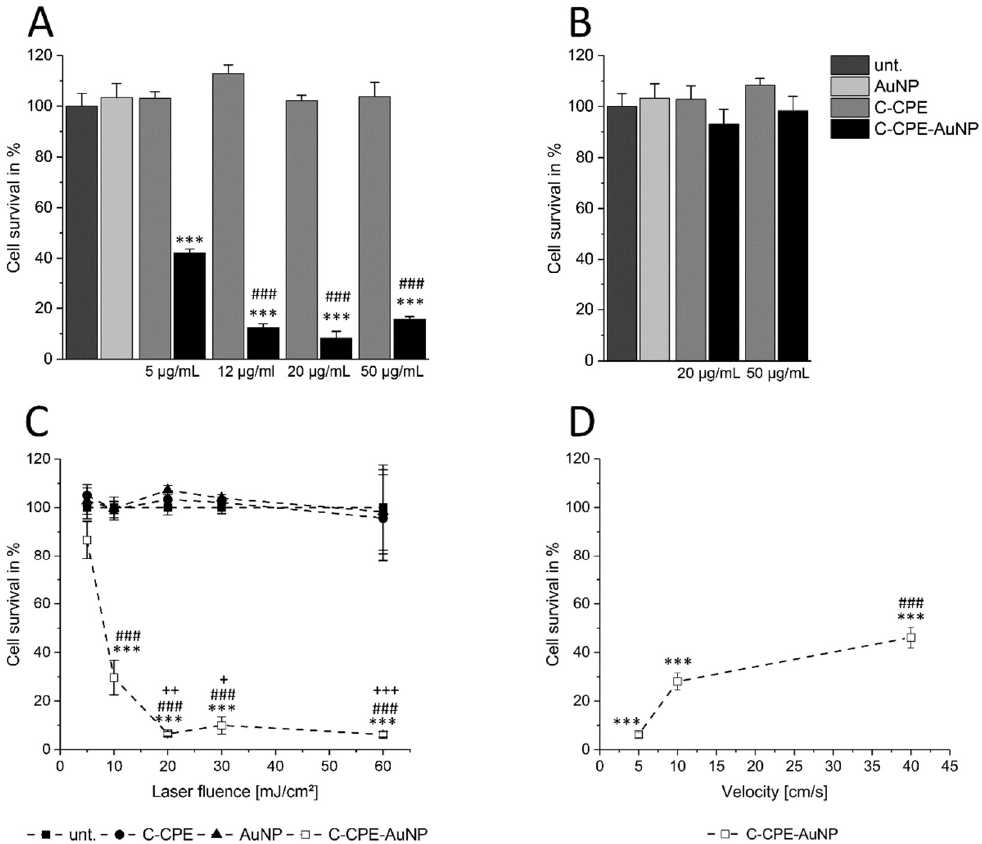
Figure 1. Increased C-CPE concentration for AuNP functionalization increased the efficiency of gold nanoparticle-mediated laser perforation (GNOME-LP)-induced cell killing of Caco-2 cells. ( A ) The survival of Caco-2 cells evaluated by propidium iodide uptake in cells treated with GNOME-LP (30 mJ/cm² at 5 mm/s) in presence of C-CPE, AuNPs, and C-CPE functionalized AuNPs (C-CPE-AuNPs). The increase of C-CPE concentration during functionalization process reduced the cell survival. The results were analyzed with Student’s t test. * Significant difference to the AuNP control group: *** p < 0.001. # Significant difference to 5 µg/mL C-CPE functionalized AuNPs: ### p < 0.001. ( B ) GNOME-LP cell killing with lower laser fluence (5 mJ/cm² at 5 mm/s) in combination with AuNPs functionalized with 20 µg/mL and 50 µg/mL C-CPE did not affect the cell survival. ( C ) Killing efficiency of AuNP functionalized with 20 µg/mL C-CPE and GNOME-LP (30 mJ/cm²) applied at indicated scanning velocity. The results were analyzed with Student’s t test. * Significant difference to the AuNP control group: *** p < 0.001. # Significant difference to velocity of 5 mm/s: ### p < 0.001. ( D ) GNOME-LP with different laser fluence (5–60 mJ/m²; 0.5 s/cm) in combination with 20 µg/mL C-CPE functionalized AuNPs. The results were analyzed with Student’s t test. * Significant difference to the AuNP control group: *** p < 0.001. # Significant difference to laser energy of 5 mJ/cm²: ### p < 0.001. + Significant difference to the laser fluence of 10 mJ/cm²: + p < 0.05, ++ p < 0.01, +++ p < 0.001. All graphs represent the mean ± SEM of cell survival relative to untreated cells (unt.).